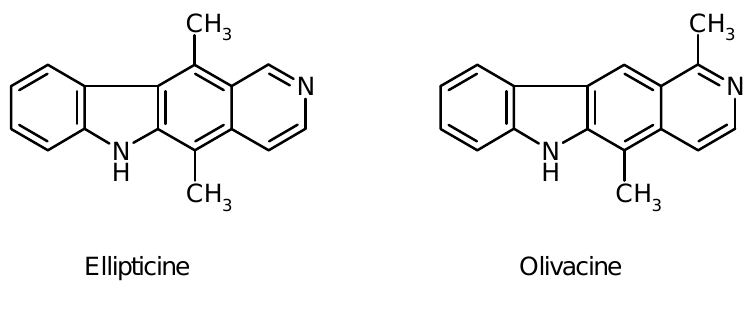
Figure 1. Structures of the alkaloids, ellipticine and olivacine .